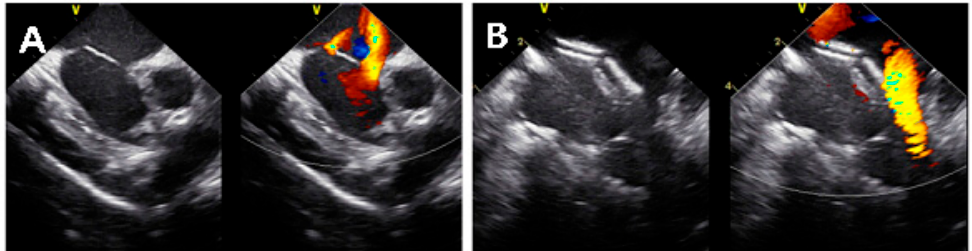
Figure 3. Images from intracardiac echocardiography during transcatheter closure of multiple atrial septal defects. ( A ) Color Doppler imaging shows two atrial septal defects near the posterior and aortic rims. ( B ) Two devices are seen placed within the atrial septum.